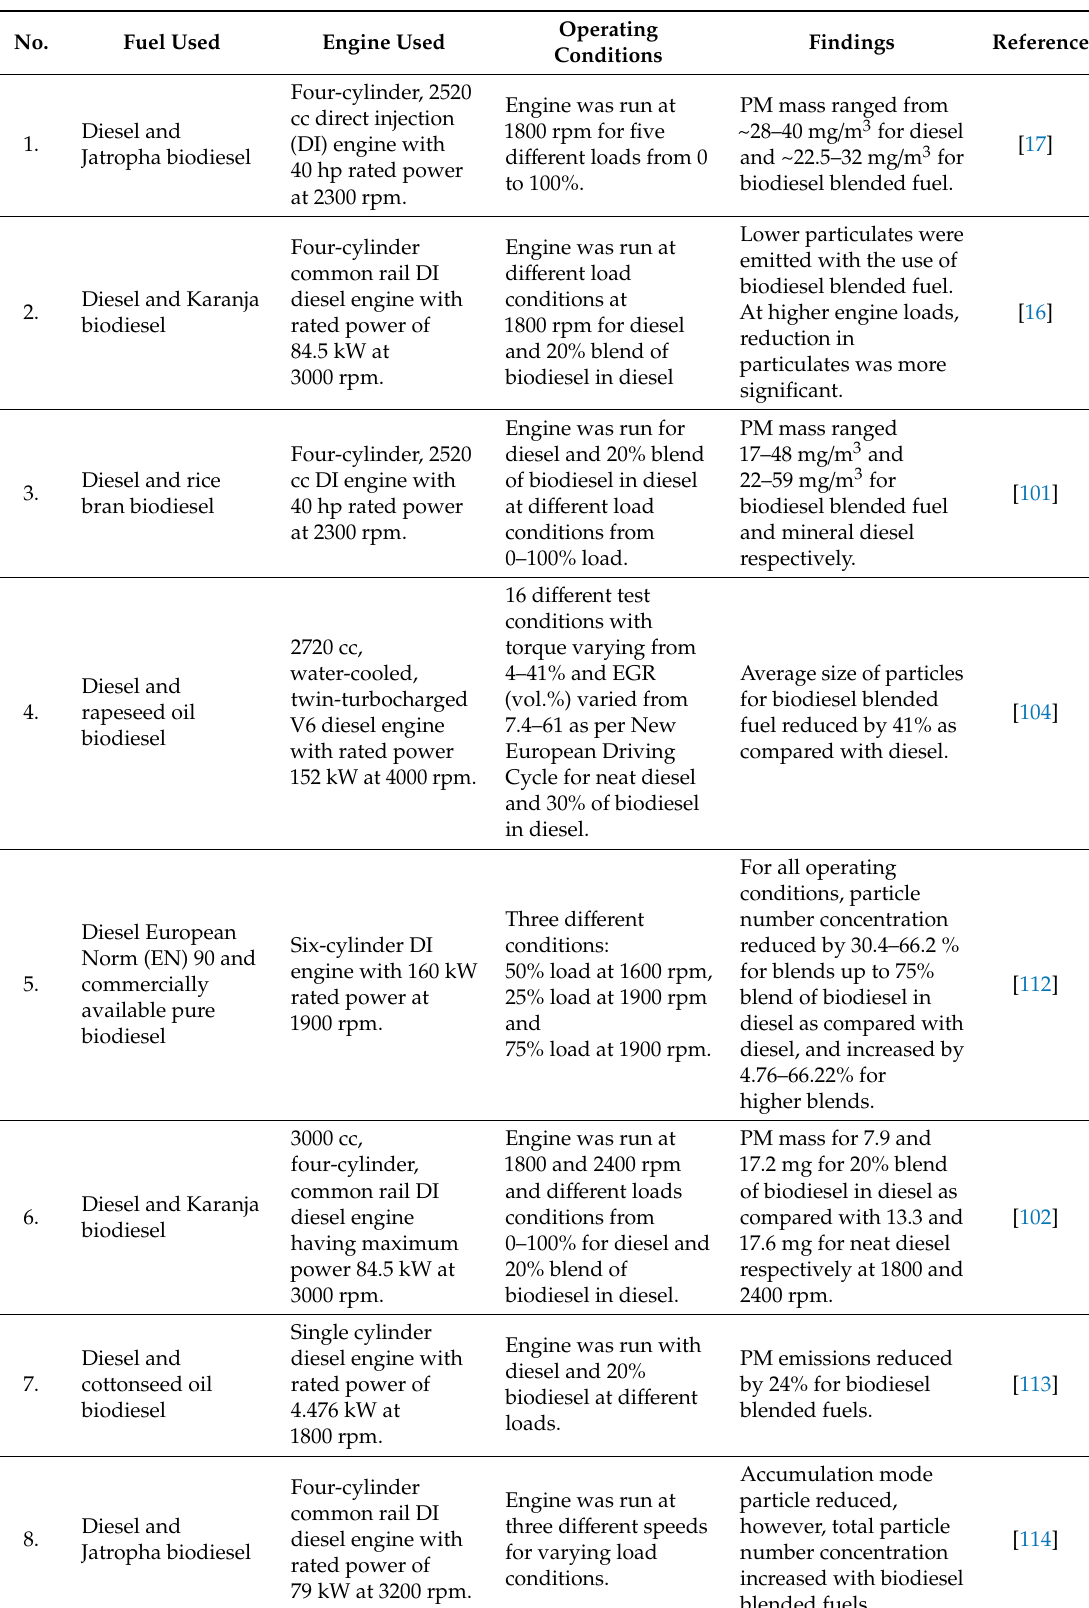
Table 1. A summary of observations made for typical biodiesel